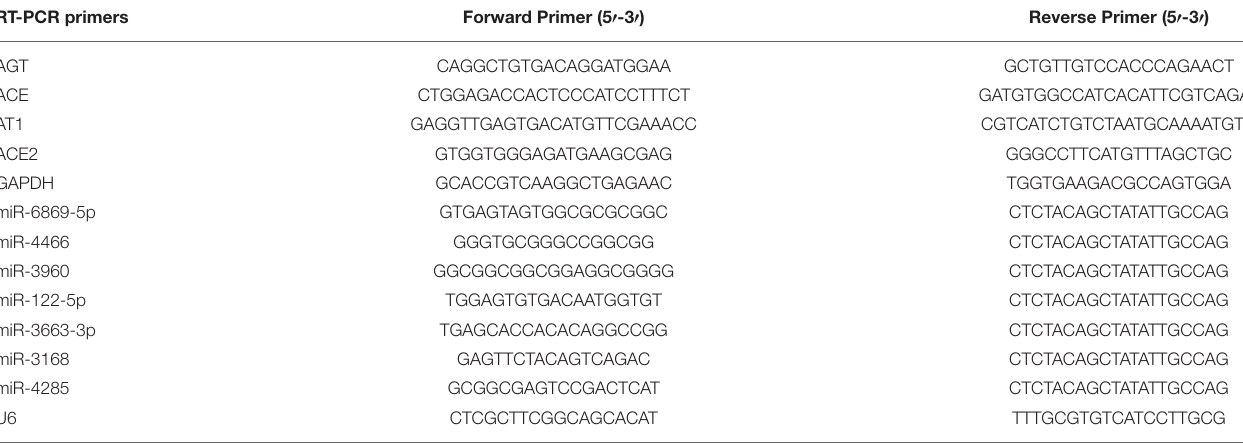
TABLE 1 | The list of primers sequences. RT-PCR primers